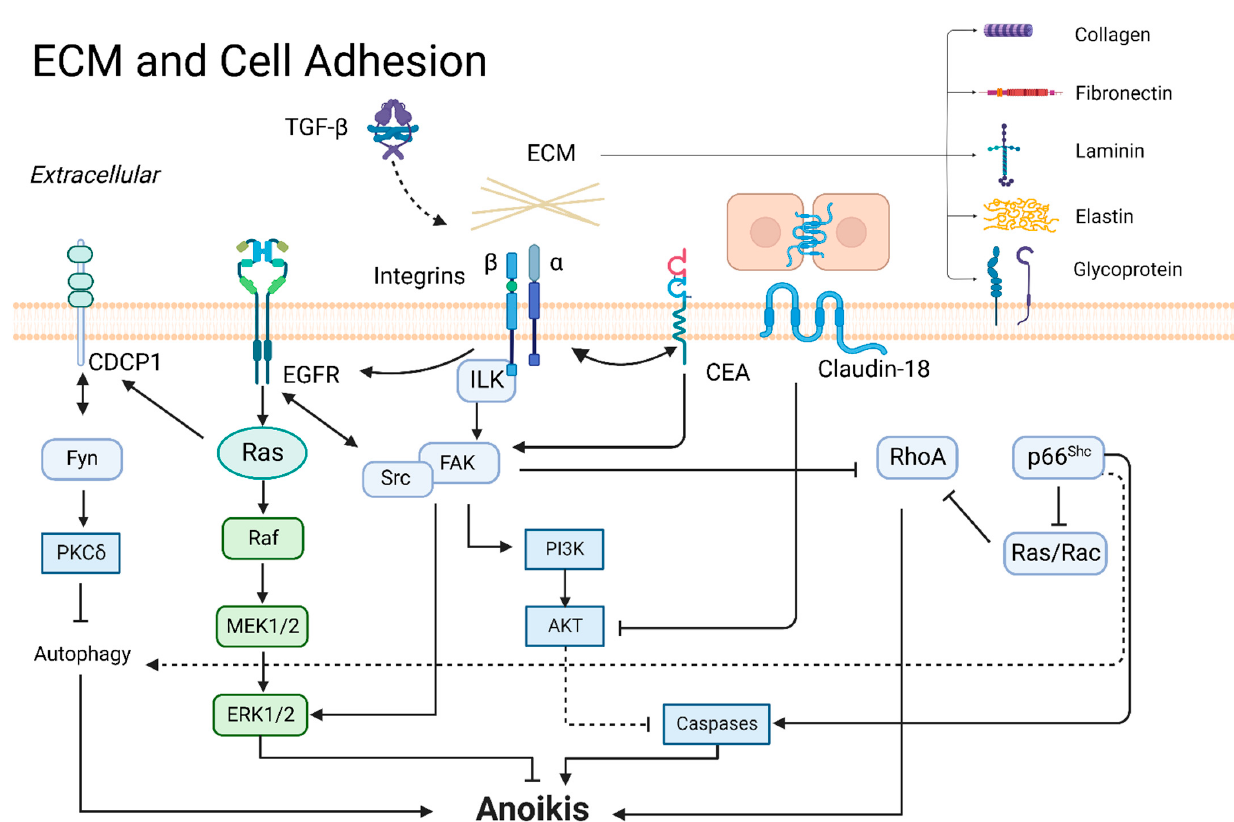
Figure 2. ECM and cell adhesion in anoikis.